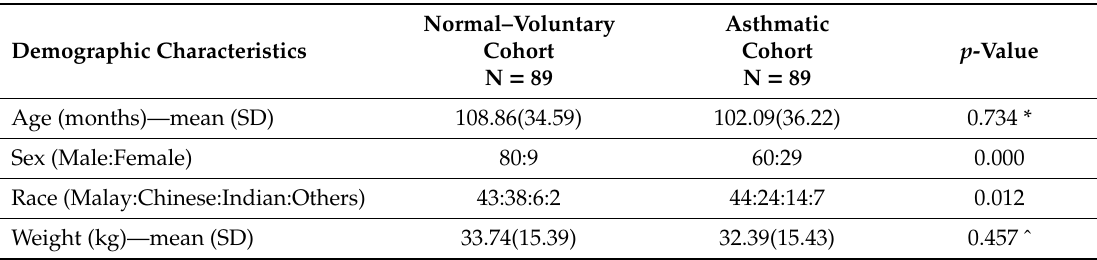
Table 1. Clinical characteristics of the study population. * Independent T -test, ˆ Mann-Whitney U test.